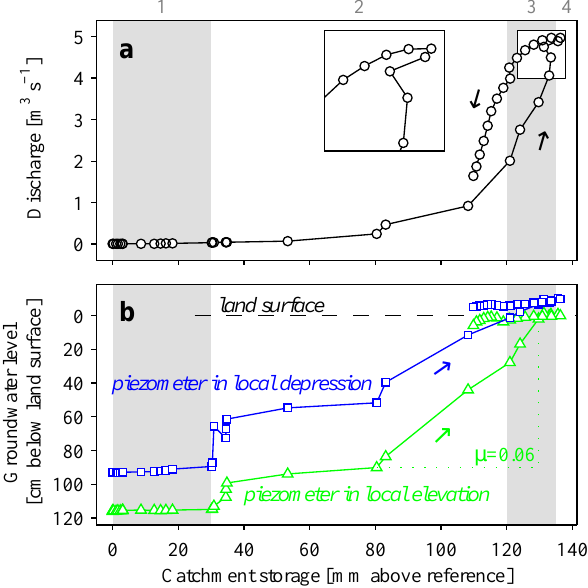
Fig. 11. Discharge at the outlet (upper panel) and local groundwater level (lower panel) as a function of estimated catchment storage for the period 25 August, 18:15UTC to 27 August, 18:00UTC. Points are drawn for each hour. The grey and white bands denote the four